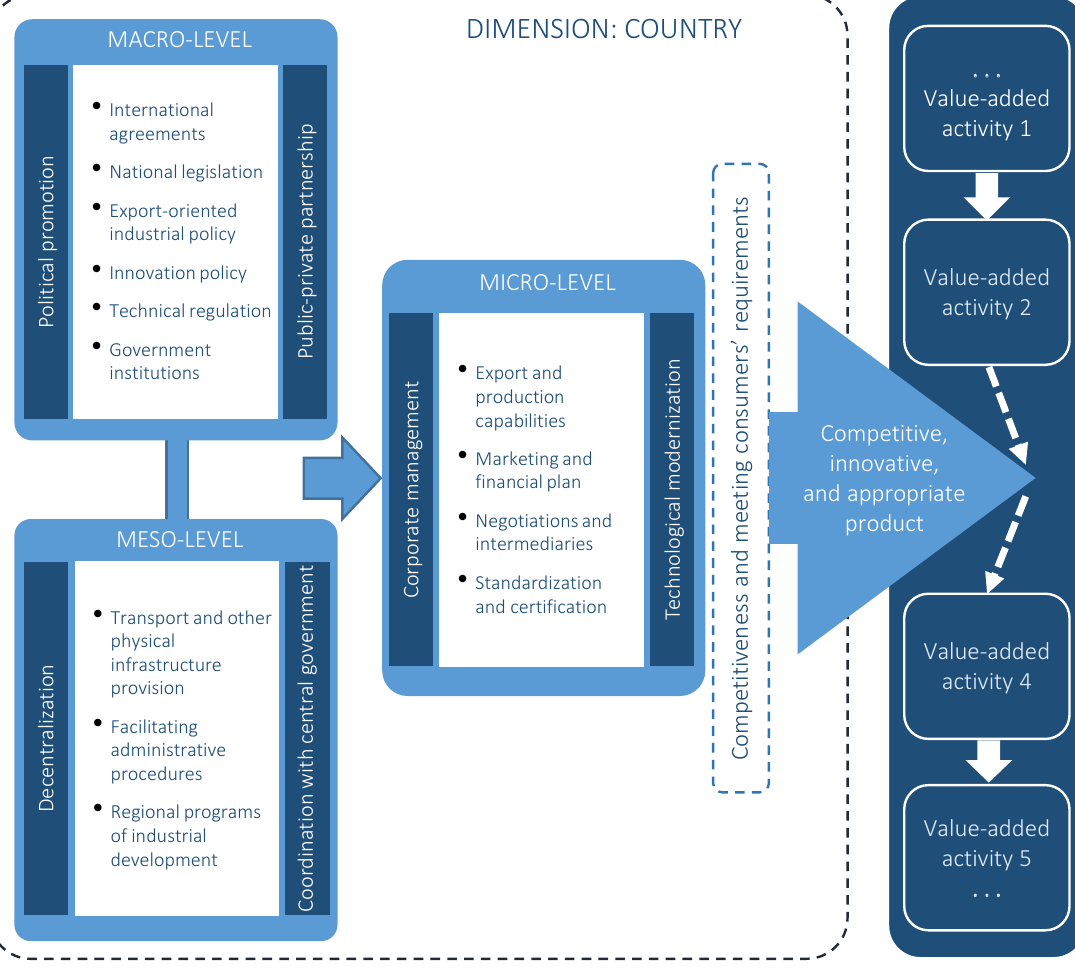
Figure 3. Institutional mechanism of country’s integration into global value